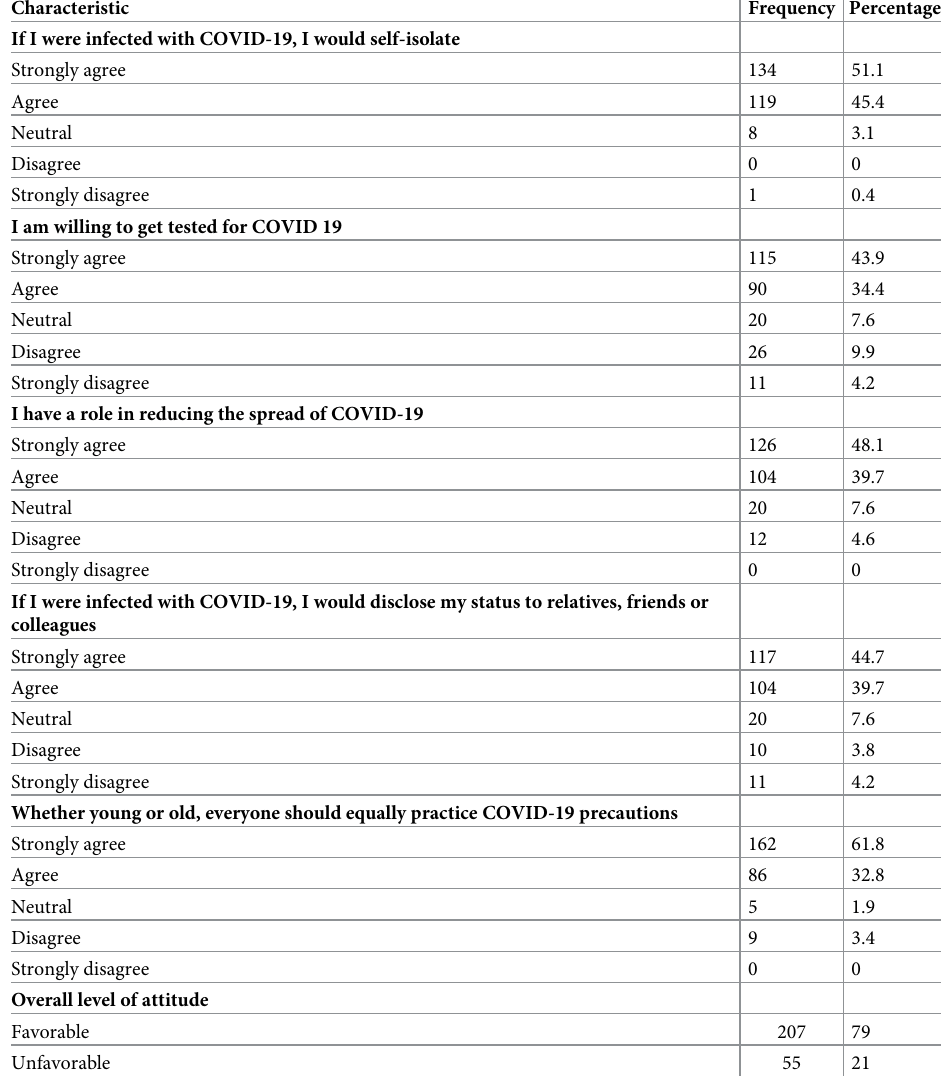
Table 4. Attitude of respondents towards COVID-19 prevention and control